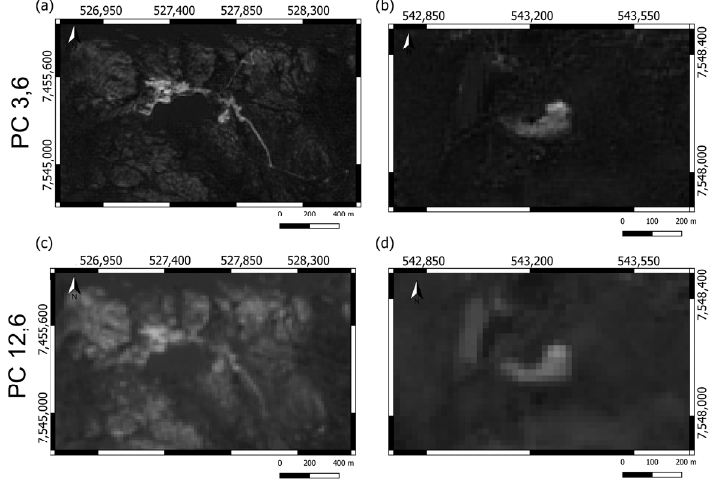
Figure 18. Comparison of PCA results of bands 3, 6 and 12, 6. ( a ) Håkonhals mine in focus for PCA 3, 6. ( b ) Jennyhaugen mine in focus for PCA 3, 6. ( c ) Håkonhals mine in focus for PCA 12, 6. ( d ) Jennyhaugen mine in focus for PCA 12, 6.